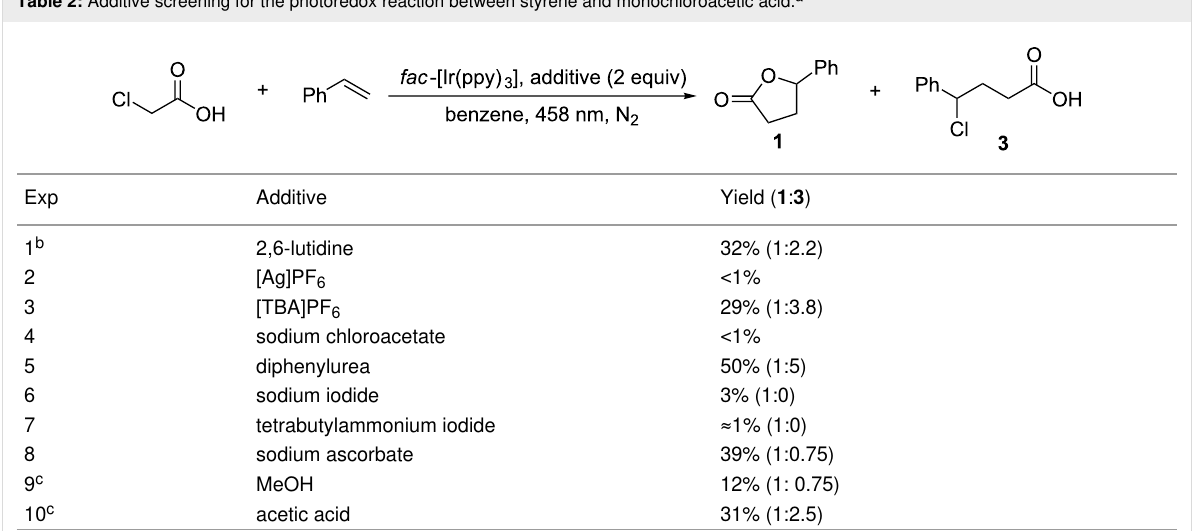
Table 2: Additive screening for the photoredox reaction between styrene and monochloroacetic acid. a